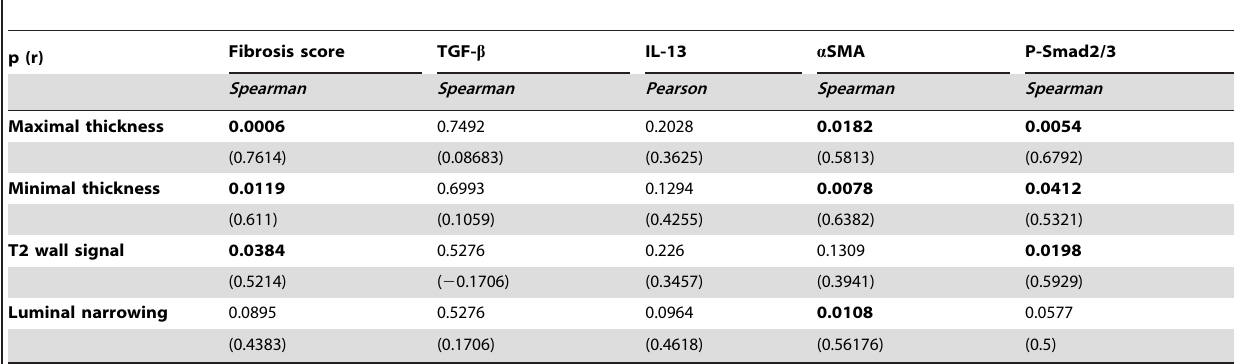
Table 1. Association between MRC criteria and fibrosis